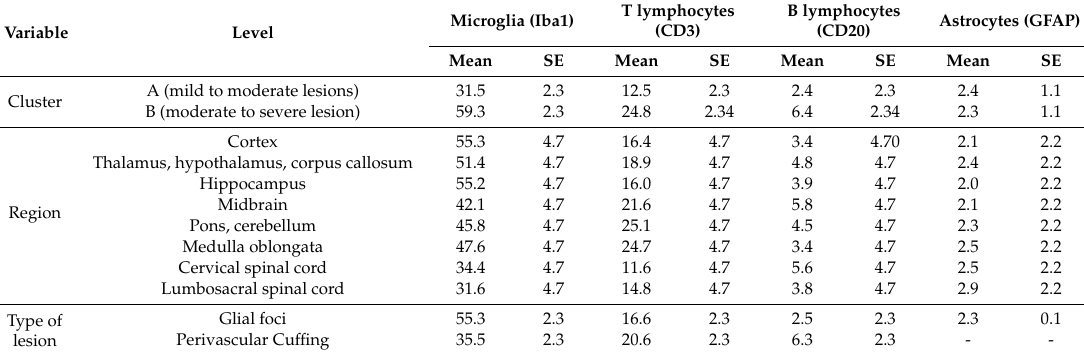
SE, standard error. Between clusters: Proportions of microglia and T lymphocytes were significantly di ff erent ( p < 0.0001), whereas proportions of B lymphocytes ( p = 0.1213) and astrocytes ( p = 0.3435) were not. Among CNS regions : Proportions of microglia in cortex and hippocampus were di ff erent from proportions in cervical and lumbosacral spinal cord ( p < 0.0001). Proportions of T lymphocytes in pons and cerebellum di ff ered from those in cervical spinal cord ( p = 0.0139). Proportions of B lymphocytes did not di ff er significantly among regions ( p = 0.5056), nor did proportions of astrocytes ( p = 0.2124). Between type of lesion : Proportions of microglia di ff ered ( p < 0.0001), whereas proportions of T lymphocytes ( p = 0.8350) or B lymphocytes ( p = 0.8659) did